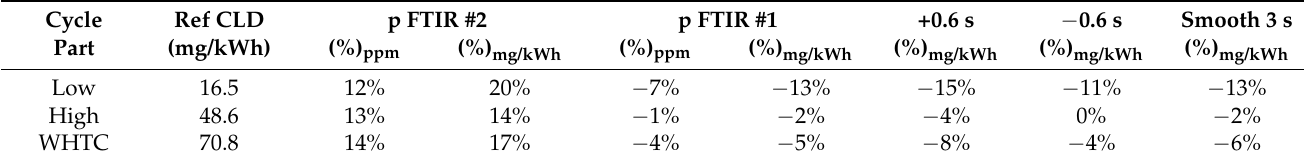
Table A2. NO x emissions of a WHTC separated at a part with low emissions, high emissions, or the complete cycle, as determined with the reference CLD. Differences of other instruments to the reference using average concentrations (ppm) or emission rates